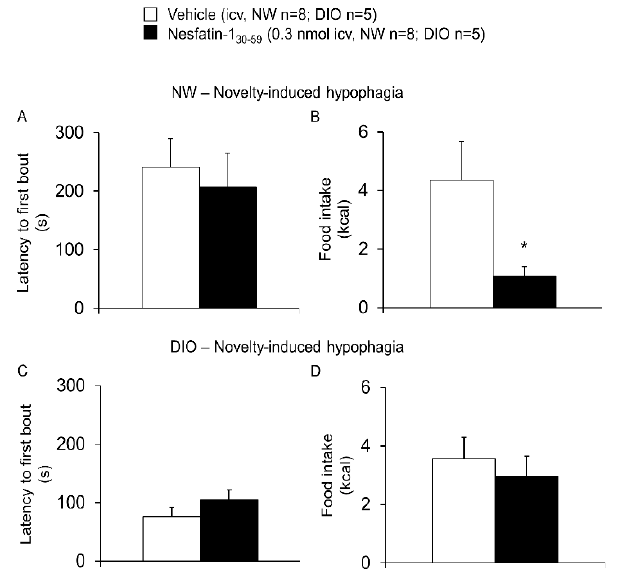
Figure 2. Nesfatin-1 30-59 increased novelty-induced hypophagia in normal weight but not in diet-induced obese rats. Intracerebroventricularly cannulated normal weight or diet-induced obese rats were injected with vehicle (5 µ L H 2 O, n = 8 and n = 5, respectively) or nesfatin-1 30-59 (0.3 nmol/rat in 5 µ L H 2 O, n = 8 and n = 5, respectively) at the beginning of the dark phase and 30 min later placed into a novel cage without bedding or enrichment. The latency to approach the food and the intake of a palatable snack was assessed for another 30 min. In normal weight rats, the latency to approach the food did not differ between the nesfatin-1 30-59 and vehicle animals ( A ), whereas the total food intake (g) was significantly decreased in nesfatin-1 30-59 injected rats ( B ). In diet-induced obese rats, neither the latency to approach the food ( C ) nor the food intake ( D ) was significantly affected by the nesfatin-1 30-59 injection (0.3 nmol/rat in 5 µ L H 2 O) compared to vehicle (5 µ L H 2 O). Data were normally distributed and are expressed as mean ± sem. Data have been analyzed by t -test. Abbreviations: DIO, diet-induced obesity; NW, normal weight. * p < 0.05 vs. vehicle.